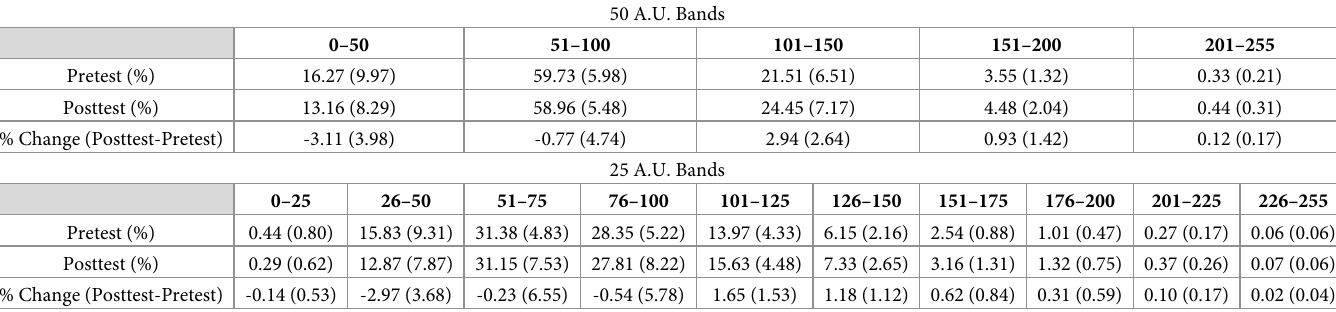
Table 1. Mean (SD) pretest, posttest, and change score values within each of the specified echo intensity bands for the immobilized vastus lateralis. 50 A.U. Bands